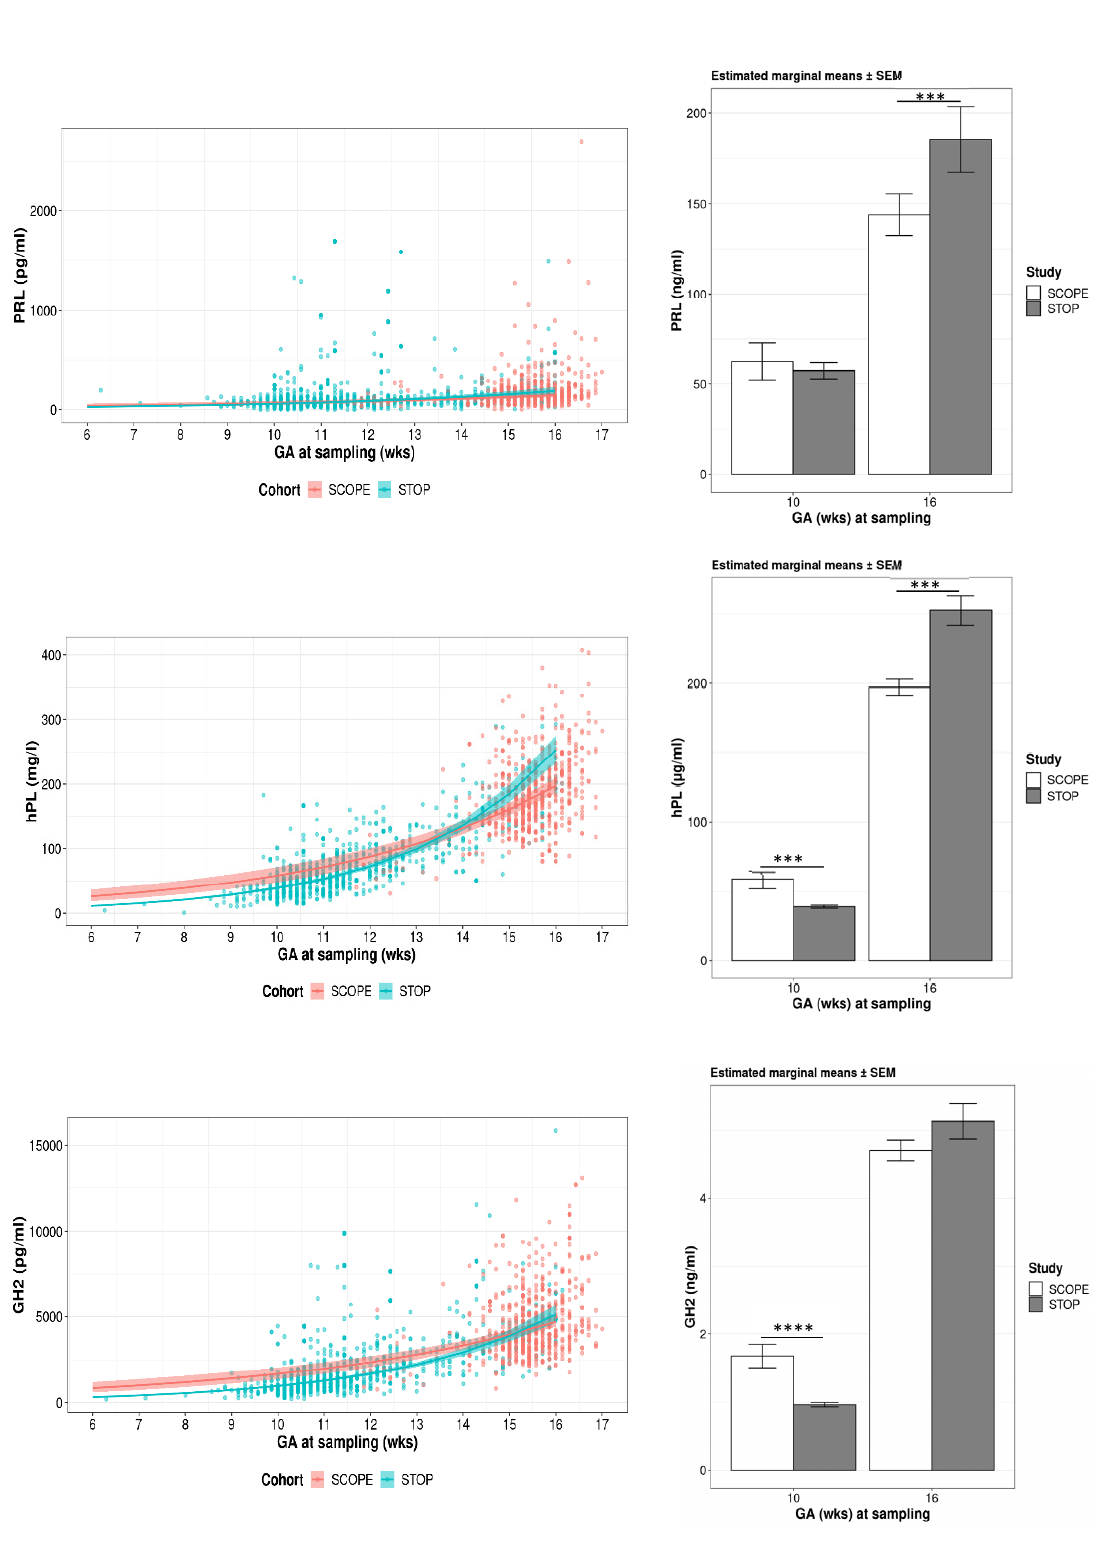
Figure 4. Serum hormone concentrations: PRL, hPL and GH2 concentrations across gestation are shown for SCOPE (N = 465) and STOP (N = 684) women with uncomplicated pregnancies. Estimated marginal means (±SEM) for SCOPE and STOP women at 10 weeks and 16 weeks of gestation are presented. Serum hormone (PRL, hPL and GH2) concentrations were analysed using a linear mixed effects model, adjusting for gestational age at sampling. Significance is indicated with asterisks (**** p < 0.0001 and *** p < 0.001).